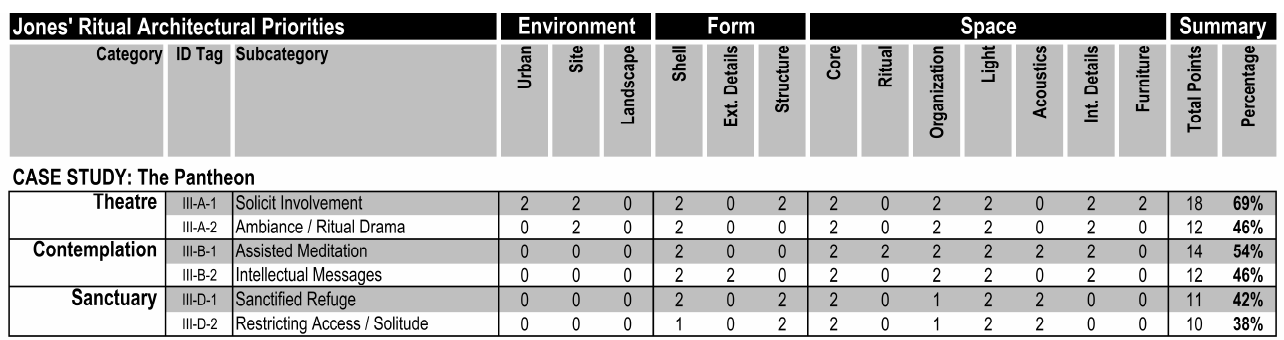
Figure 5. Graphical analysis summary for the Pantheon is provided in a matrix to help researchers quickly identify the priorities for various ritual contexts on both the macro and micro scale ( top ). A numerical breakdown of the same graphical analysis is also provided ( bottom ).